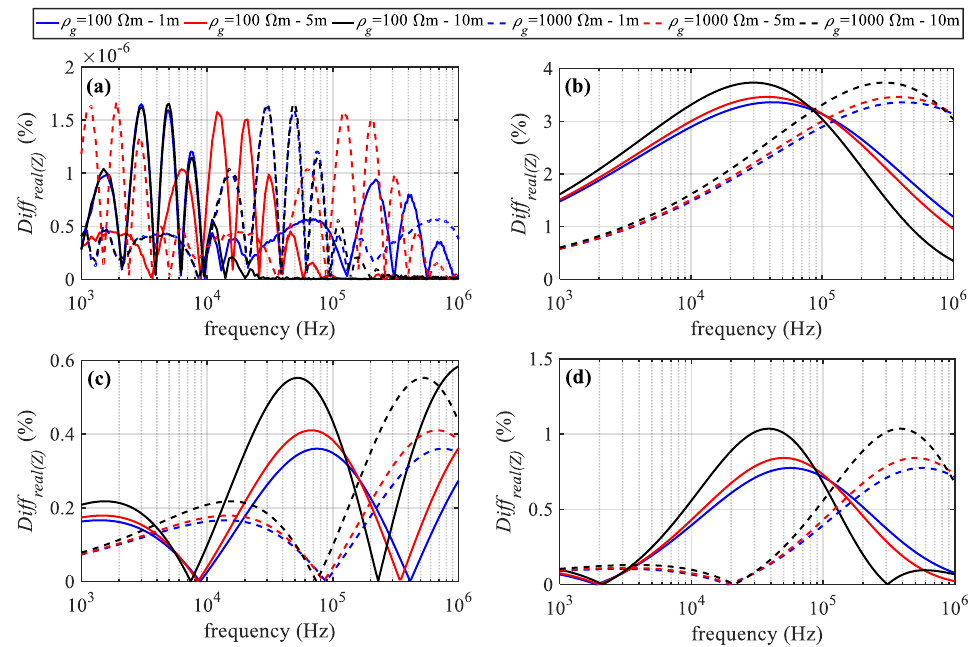
Figure 9. Differences in the real part of Z 13 in NB using the closed-form expression of ( a ) Carson, ( b ) Dubanton ( c ) Noda and ( d ) Alvarado-Betancourt.